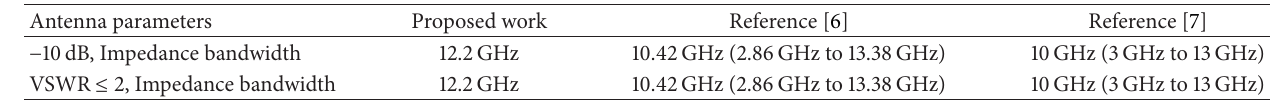
Table 3: Validation of antenna parameters of different geometry with reference paper.